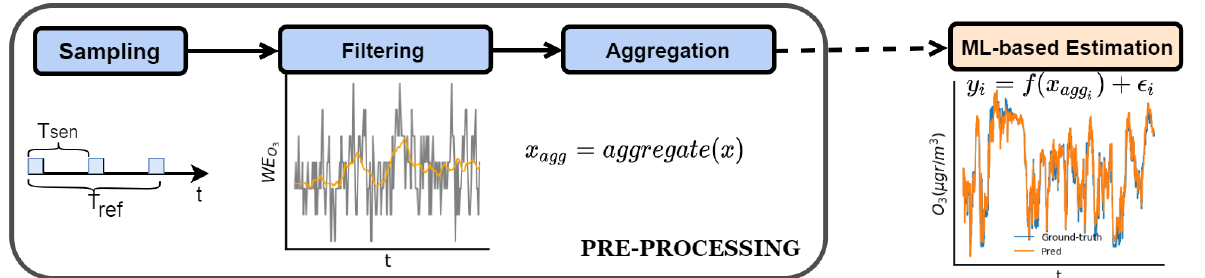
Figure 2. Sensor data gathering pipeline: from sensor sampling to machine learning estimation. First, sensors are sampled every T sen , then the samples collected during this period are filtered to eliminate possible outliers and aggregated to be sent to the cloud. There, the air pollution concentrations are estimated using the calibration